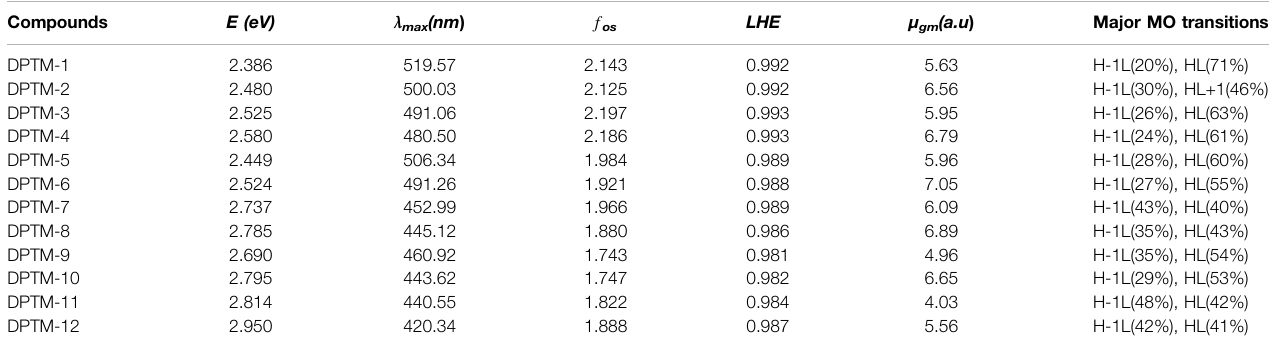
TABLE6| Transitionenergy( eV ),maximumabsorptionwavelengths( λ max ),oscillatorstrengths( f os ),light-harvestingef fi ciency( LHE ),transitionmoment( M gm X a.u .),andmajor molecular orbital transitions of the designed compounds. Compounds E (eV) λ max (nm ) f os LHE μ gm (a.u